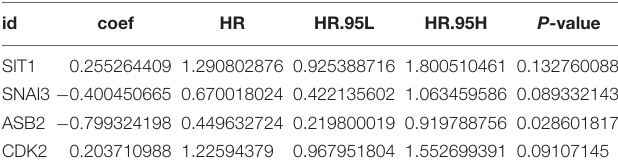
TABLE 6 | The analysis of multivariate regression about four genes.